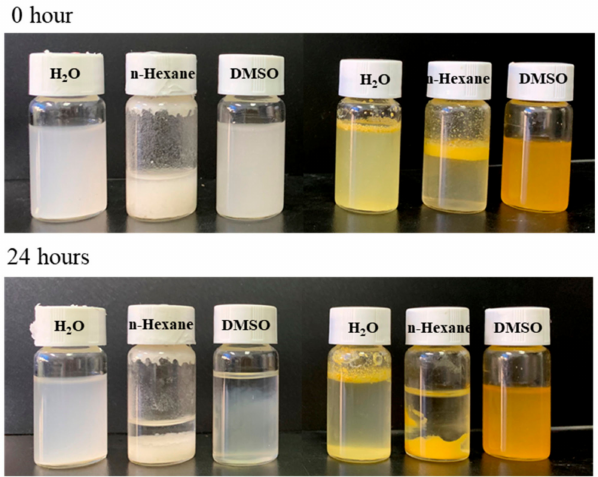
Figure 5. Photograph of two separate CNC samples: left: the CNC and right: the CNC-PFAZO.